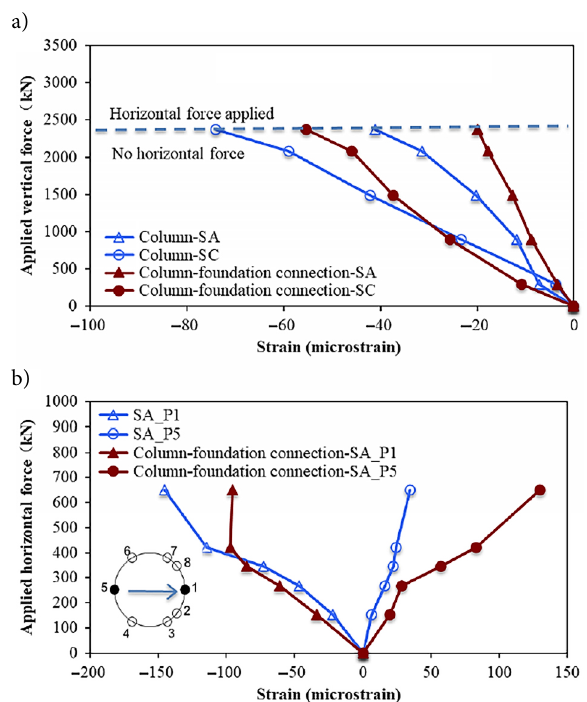
Figure 5. Normal strain versus applied vertical force for Type A in Stage 2: a – At Sections A and D of column; b – At Sections A and C of column-foundation connection